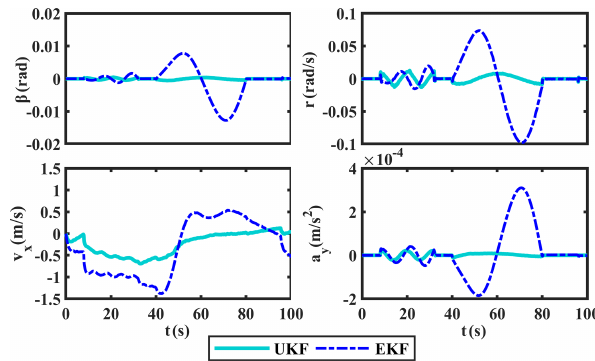
Figure 4. The structure of the simulator based on the UKF algo- rithm.